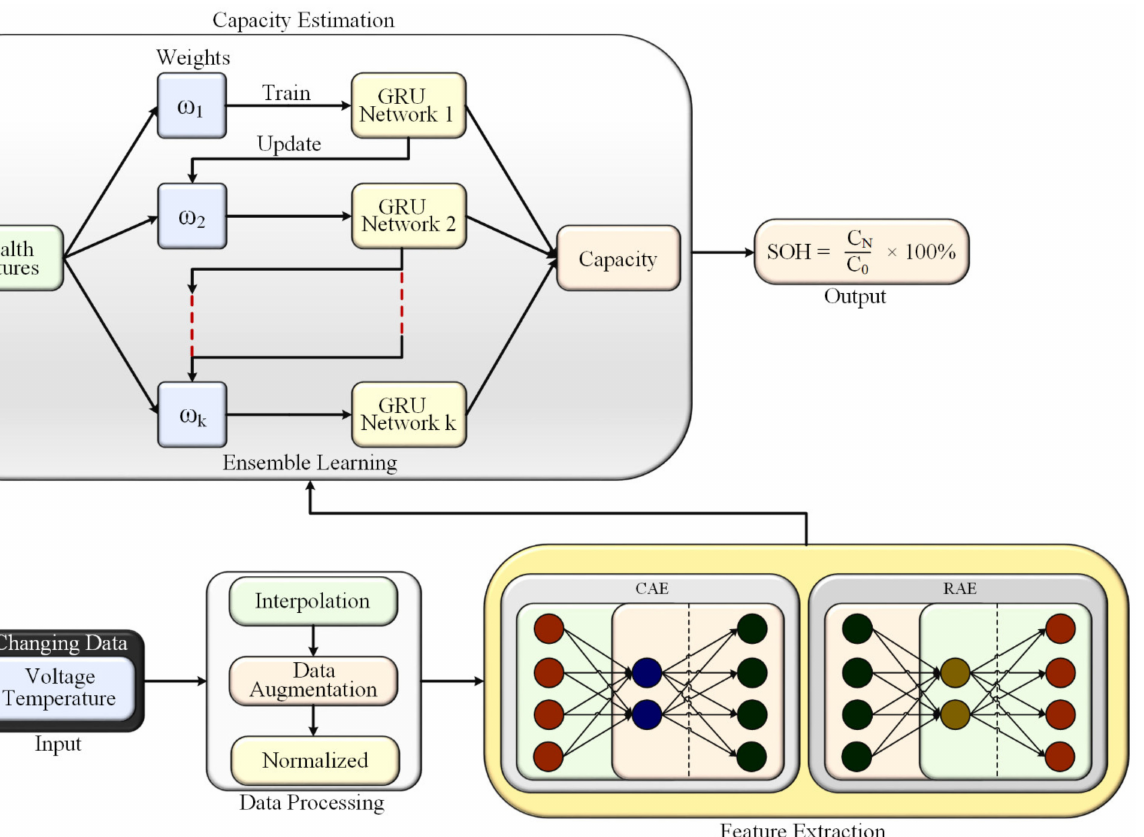
Figure 11. Autoencoder and ensemble learning-based SOH